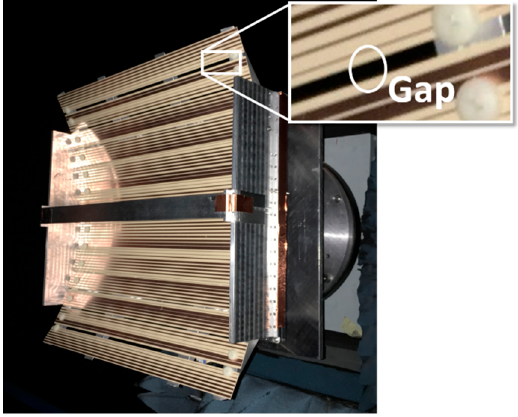
Figure 5. Manufactured segmented reflectarray. The unwanted gap between adjacent segments due to manufacturing errors are also shown.